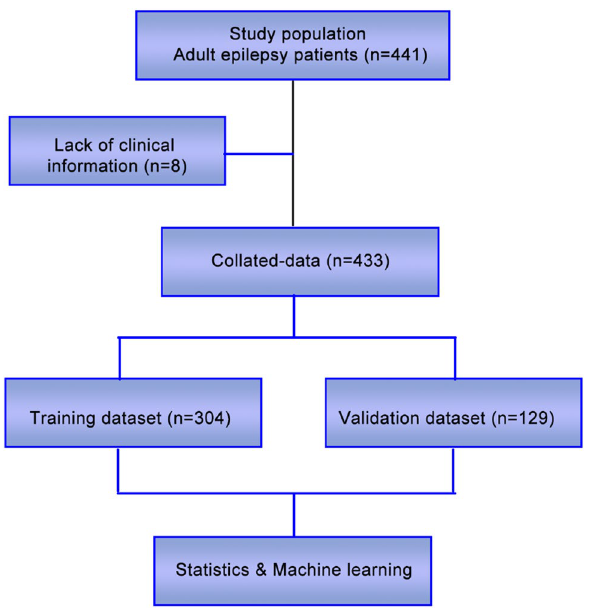
Figure 1. Clinical data screening